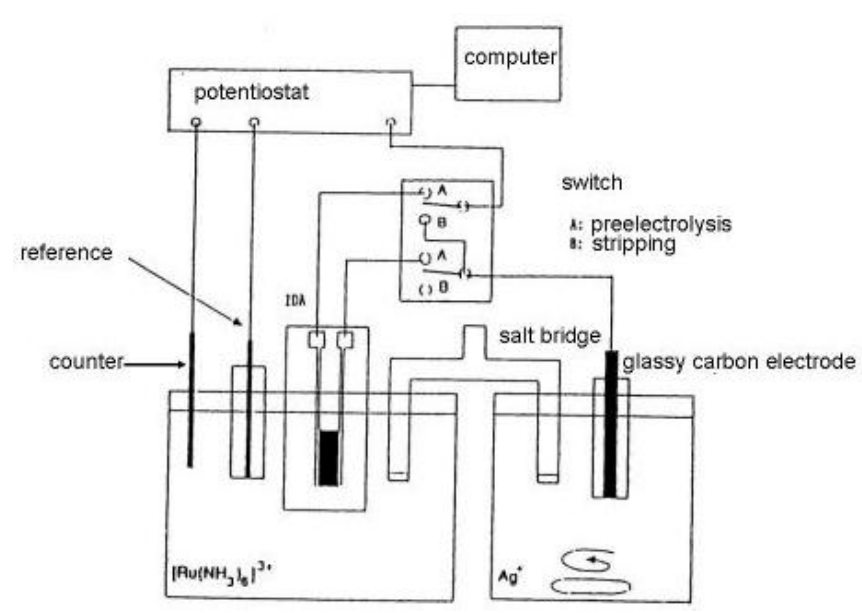
Figure 11. SSV measuring system scheme